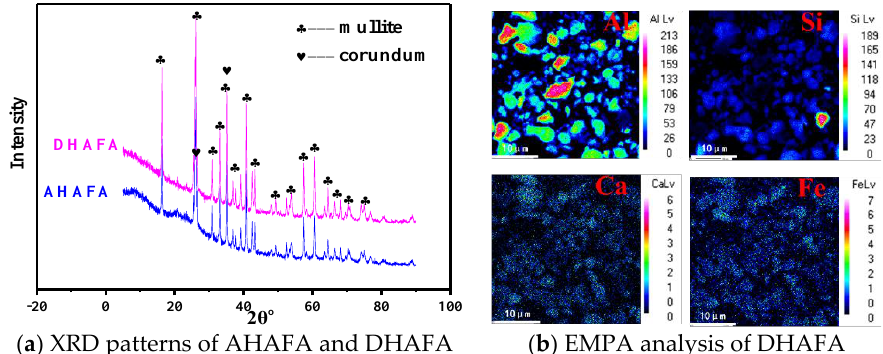
Figure 6. XRD ( a ) and EMPA ( b ) analysis of different treated HAFA samples.